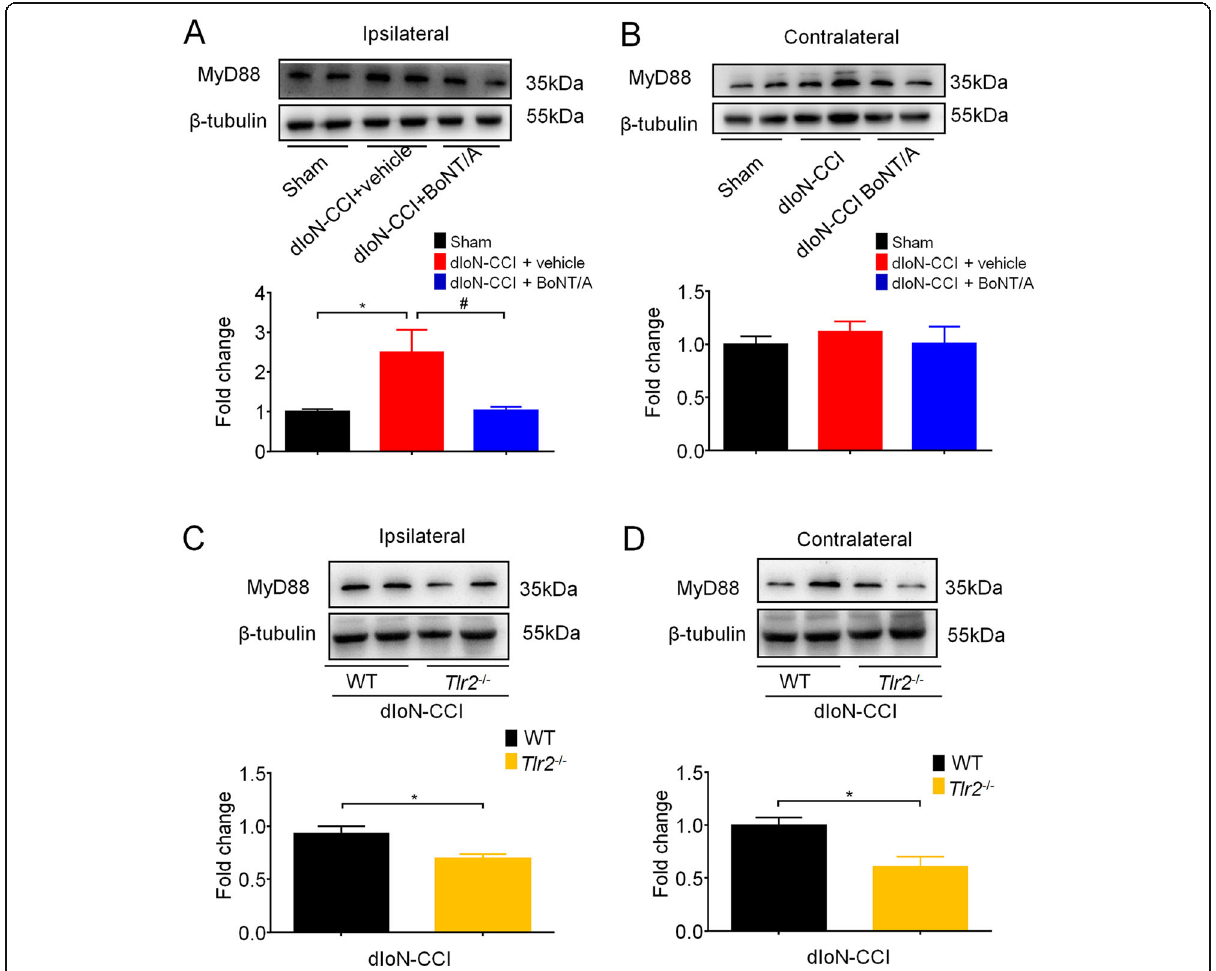
Fig. 9 Western blotting analysis showed the expression changes of Myd88 in the bilateral TNC in mice. a The expression of MyD88 was increased by dIoN-CCI surgery compared with the sham group, and BoNT/A injection decreased this upregulation. b The expression of MyD88 did not change in the contralateral TNC by dIoN-CCI surgery compared with the sham group. c - d The expression of MyD88 in the ipsilateral and contralateral TNC was significantly reduced in Tlr2 − / − mice compared with wild-type mice following dIoN-CCI surgery. Data was expressed as Mean ± SEM. ( n = 4 each group, * P < 0.05 compared with the sham group. # P < 0.05 compared with the TN group, unpaired Student ’ s t-test) TNC, Trigeminal nucleus caudalis; dIoN-CCI, Chronic constriction injury of distal infraorbital nerve; BoNT/A, Botulinum toxin